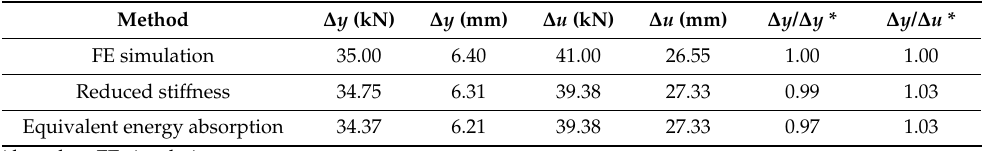
Figure 8. Analytical approach to determine control points. ( a ) Reduced stiffness equivalent elasto- plastic yield. ( b ) Equivalent elasto-plastic energy absorption. Table 4. Control points of the load-deformation